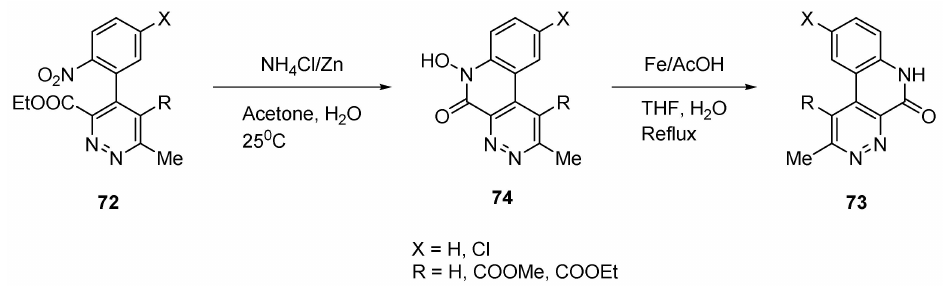
Scheme 17. Reductive cyclization leading to